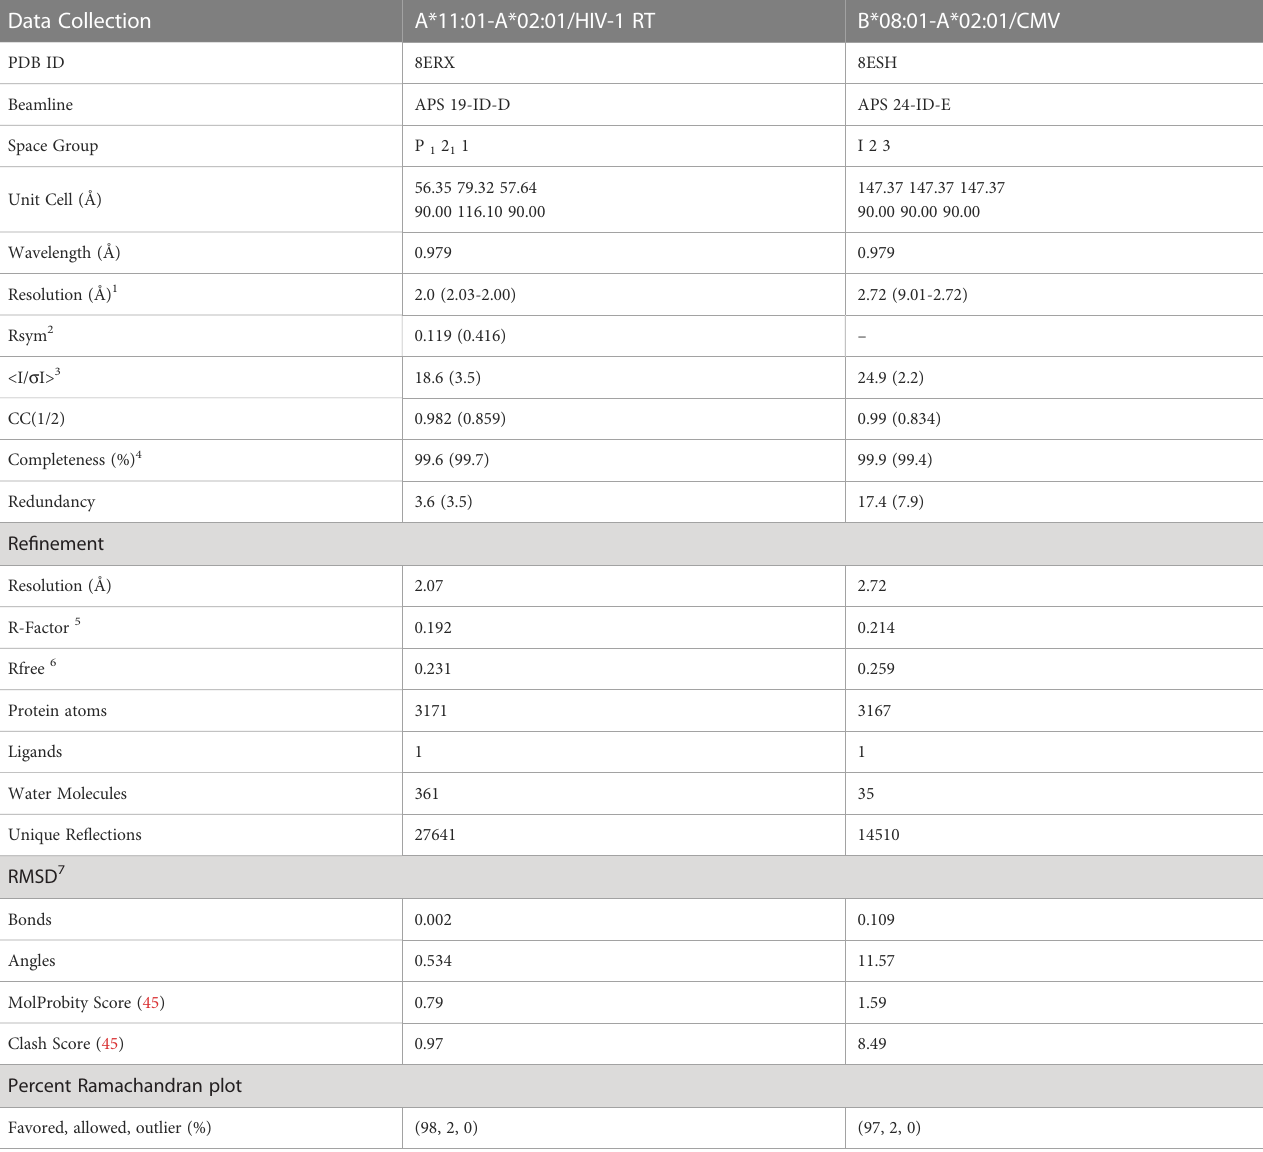
TABLE 2 Crystallography data collection and re fi nement statistics for the HLA-A*11:01-A*02:01/HIV-1 RT and B*08:01-A*02:01/CMV chimeras. Data